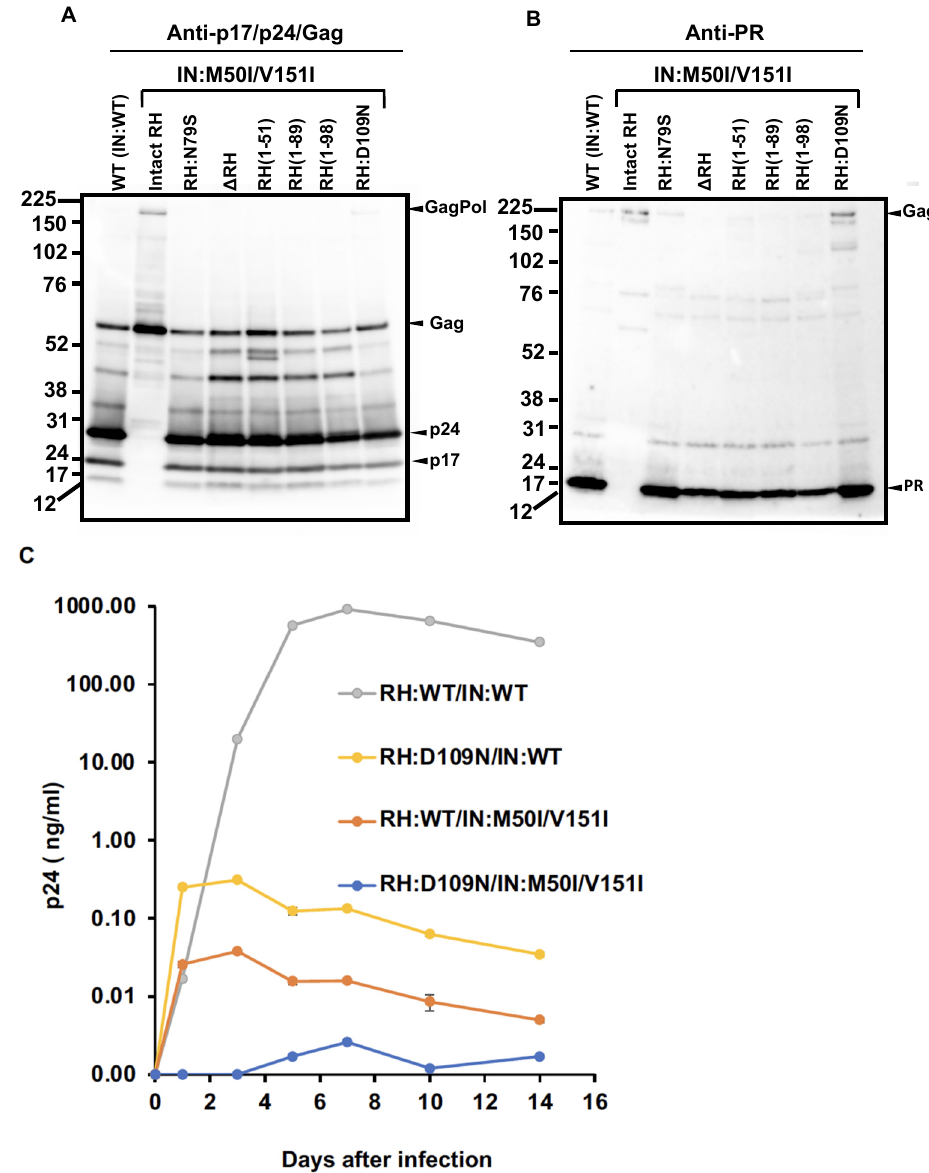
Figure 2. RH:D109 regulates virus release and autoprocessing in the presence of IN:M50I/V151I. ( A , B ) Virus particles are isolated using ultracentrifugation, as described in the Materials and Methods (Section 2.4), and 1 μ g of viral lysates was subjected to WB. Gag/GagPol-cleaved products and PR were detected by rabbit polyclonal anti-p17/p24/Gag ( A ) and anti-PR ( B ), as described in the Materials and Methods section. ( C ) PHA-stimulated primary CD4(+) T cells obtained from healthy donors were infected with 10 ng p24 amounts of HIV(WT) or variants, as described in the Materials and Methods (Section 2.6). The infected cells were cultured for 14 days with a changing medium every 3 to 4 days. HIV replication was monitored using a p24 antigen capture kit. Representative data from three independent assays are presented as means ± standard deviations (SDs) (n = 3). The defect of HIV(IN:M50I/V151I) in the virus-release process was partially rescued in the absence of RH (Figure 1C), implicating that the RH domain in the GagPol negatively regulates the virus release in the defective virus. To define whether the RH domain affects the virus release of HIV(IN:WT), the RH domain-deleted HIV(IN:WT), HIV( Δ RH/IN:WT) was created, and the virus release was assessed. If the RH domain negatively regulated the virus release, we expected that the release of HIV( Δ RH/IN:WT) might be increased; however, the mutant demonstrated 53 ± 11% (n = 3, p < 0.05) of HIV(WT) (Figure 3A), indicating that the RH domain positively regulates the virus release of HIV(WT). WB demonstrated that HIV( Δ RH/IN:WT) was able to process Gag and GagPol (Figure 3B,C); thus, the RH domain is involved in virus release.